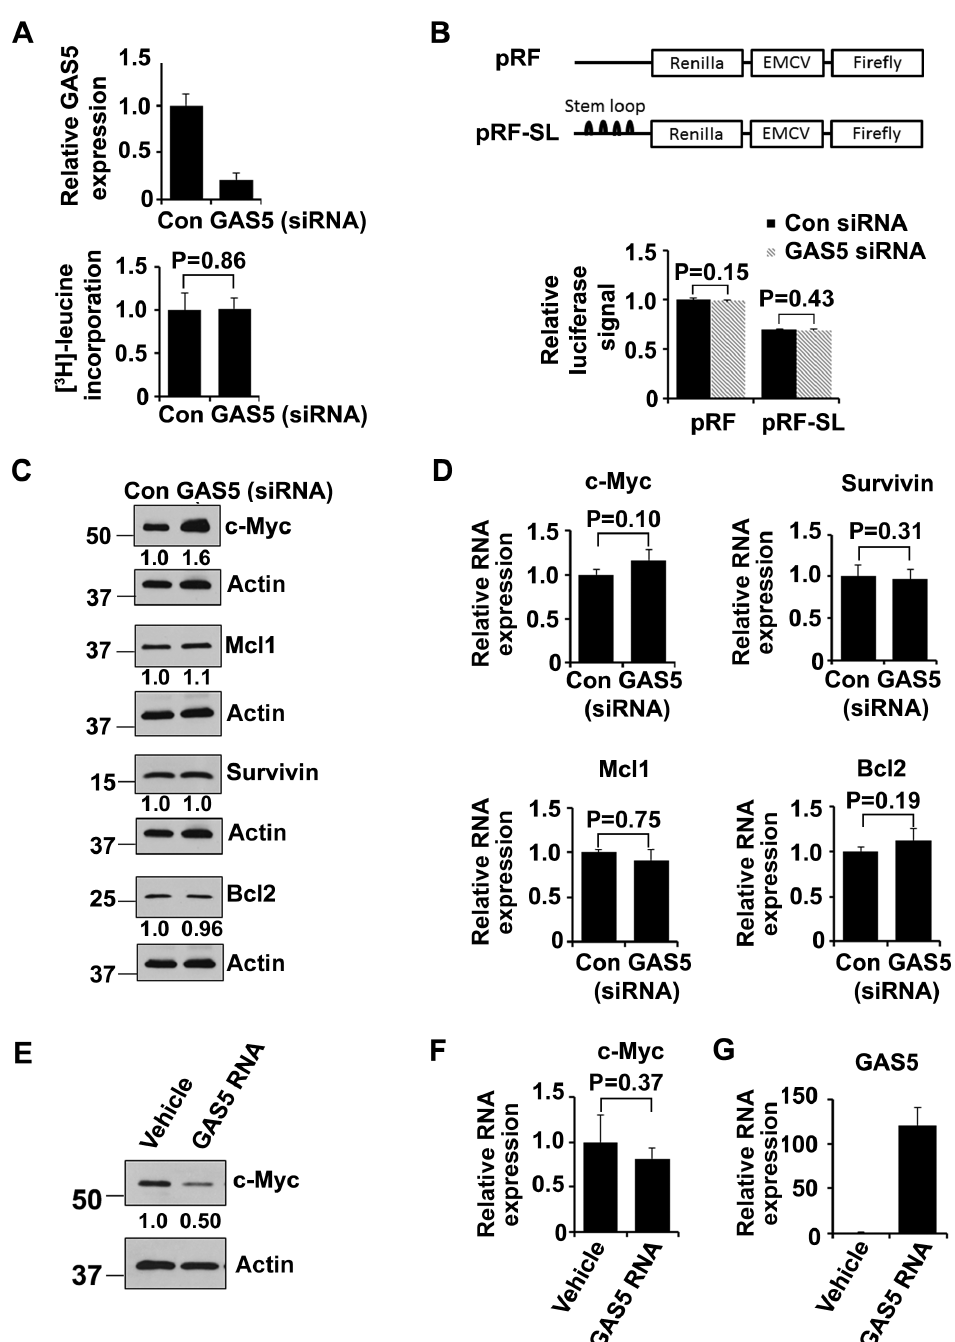
Figure 3. GAS5 suppresses c-Myc expression at protein level. ( A ) GAS5 was knocked down by siRNA in HEK-293T cells, and global protein translation was measured by [ 3 H]-leucine incorporation assay. Bars represent mean 6 SD from 3 replicates for Q-PCR and 6 replicates for [ 3 H]-leucine incorporation assay. The experiments were performed two times. ( B ) pRF and pRF-SL plasmid were transfected into HEK-293T cells and cap- dependent protein translation efficiency was evaluated by luciferase assay. Bars represent mean 6 SD from 4 replicates. The data were repeated three times. ( C ) The protein level of c-Myc (P=0.007), Mcl1 (P=0.88), survivin (P=0.47) and Bcl2 (P=0.47) was assessed by western blot (n=3) after the cells were treated with GAS5 or control siRNA. ( D ) The mRNA level of c-Myc (P=0.10), Mcl1 (P=0.75), survivin (P=0.31) and Bcl2 (P=0.19) was quantified by Q-PCR after the cells were treated with GAS5 or control siRNA. Bars represent mean 6 SD from 3 replicates. The experiment was repeated three times. ( E ) The protein level of c-Myc (P=0.005) was assessed by western blot (n=3) after the cells were transfected with in vitro transcribed GAS5 RNA. ( F-G ) The mRNA level of c-Myc (P=0.37) ( F ) and GAS5 ( G ) was quantified by Q-PCR after the cells were transfected with in vitro transcribed GAS5 RNA. Bars represent mean 6 SD from 3 replicates. The experiment was performed three times.